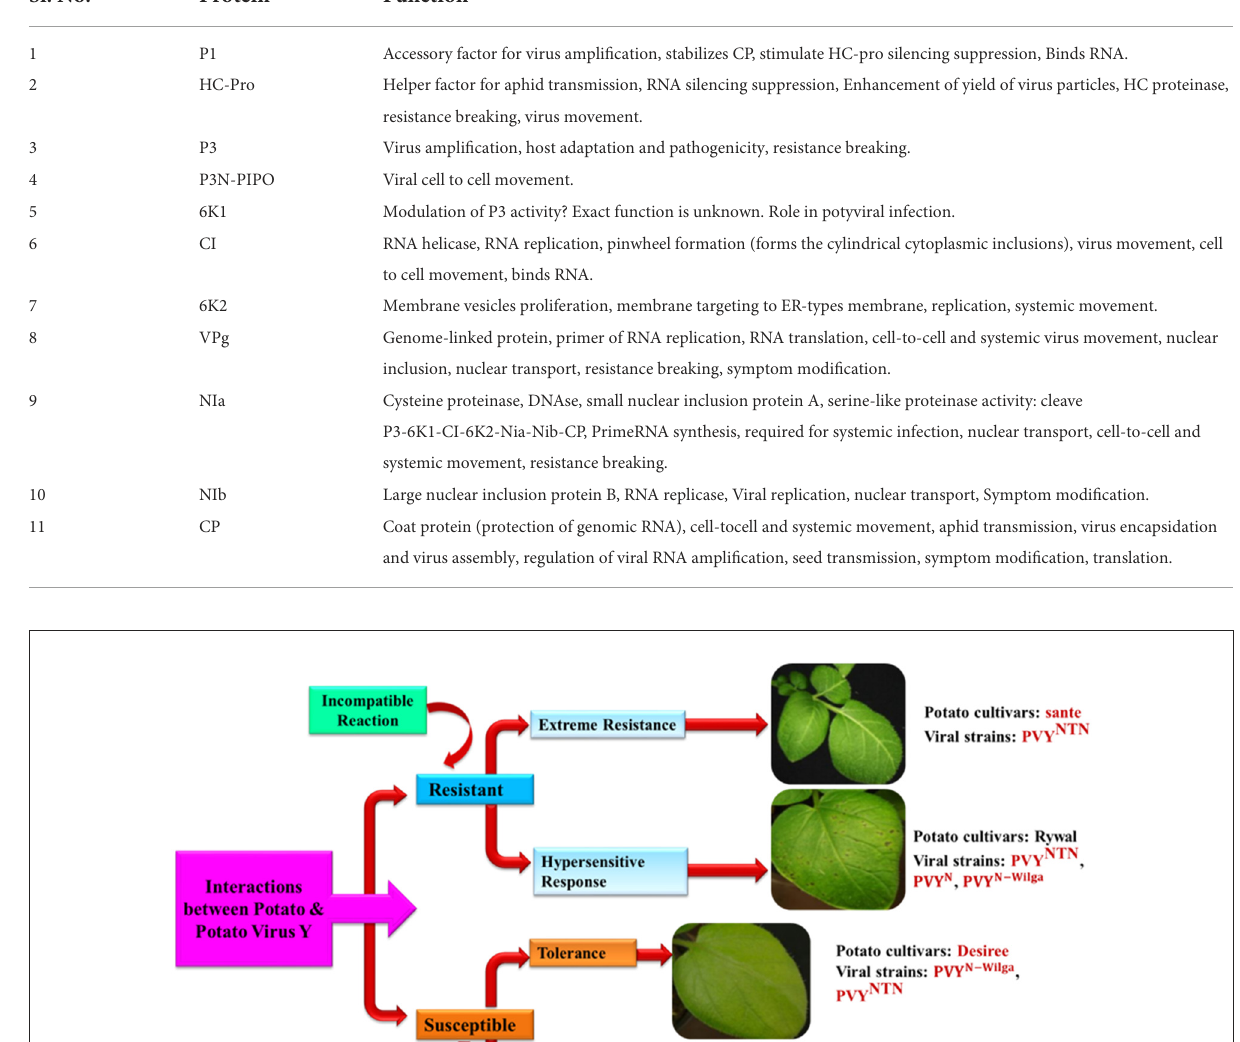
TABLE 2 Potyvirus proteins and their functions (Hu et al., 2011; Hillung et al., 2013; Revers and Garcia, 2015; Lacomme et al., 2017; Valli et al., 2018). Sl. No.